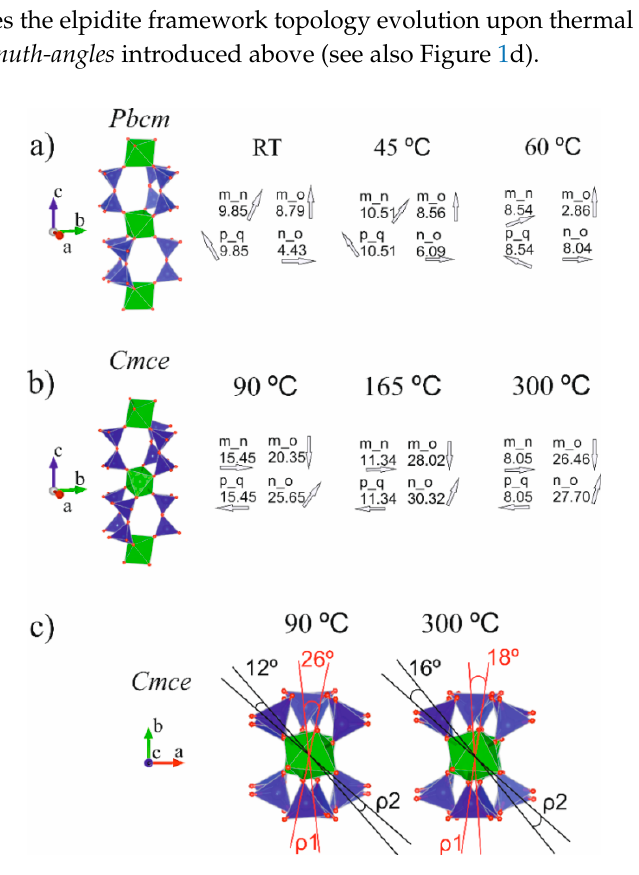
Figure 5. Elpidite framework topology evolution upon thermal treatment (selected data) in terms of the twist- tilt- and azimuth-angles of Pbcm phases at RT - 60°C ( a ) and Cmce phases at 90 - 300°C in two different directions: along a -axis ( b ) and along c -axis ( c ) (see also data in Table 5).